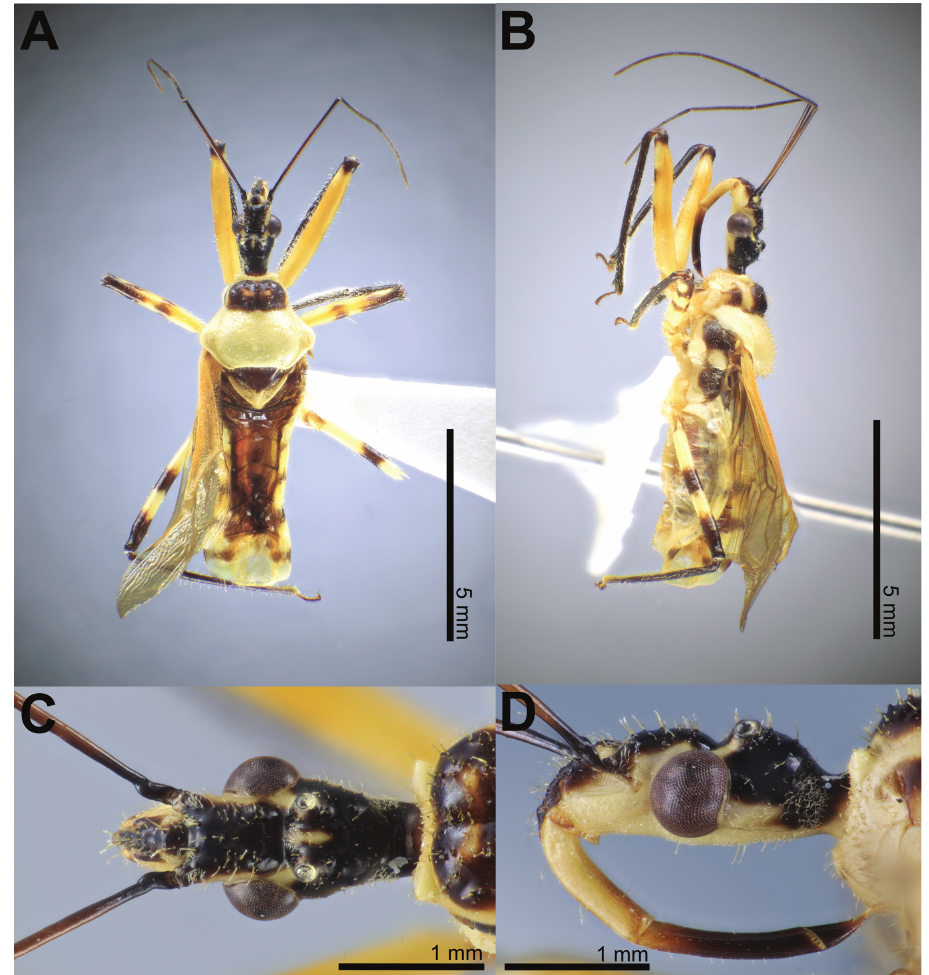
Figure 19. Biasticus luteicollis Ha, Truong & Ishikawa, sp. nov., holotype, ♂ , HNL2018-025 A body in dorsal view B body in lateral view C head in dorsal view D head in lateral